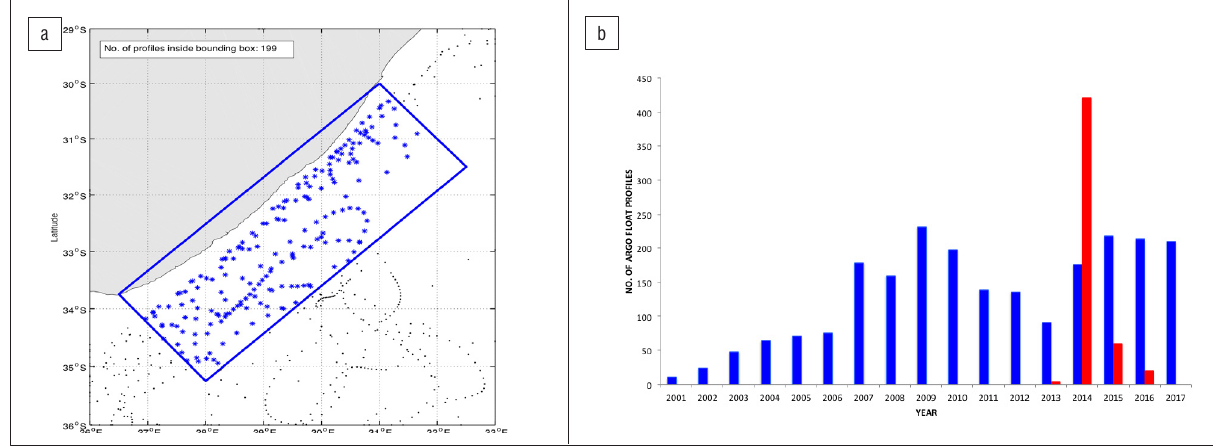
Figure 2: (a) Map of the east coast of South Africa for the 18 high-resolution floats used in the mesoscale eddy and Agulhas Current experiments, with the Agulhas Current region depicted (as per Beal et al. 2 ) as a blue rectangle. (b) Histogram depicting, within the Agulhas Current bounding box, the profiles from standard profiling Argo floats (blue) and high-resolution Argo floats (red) per year.